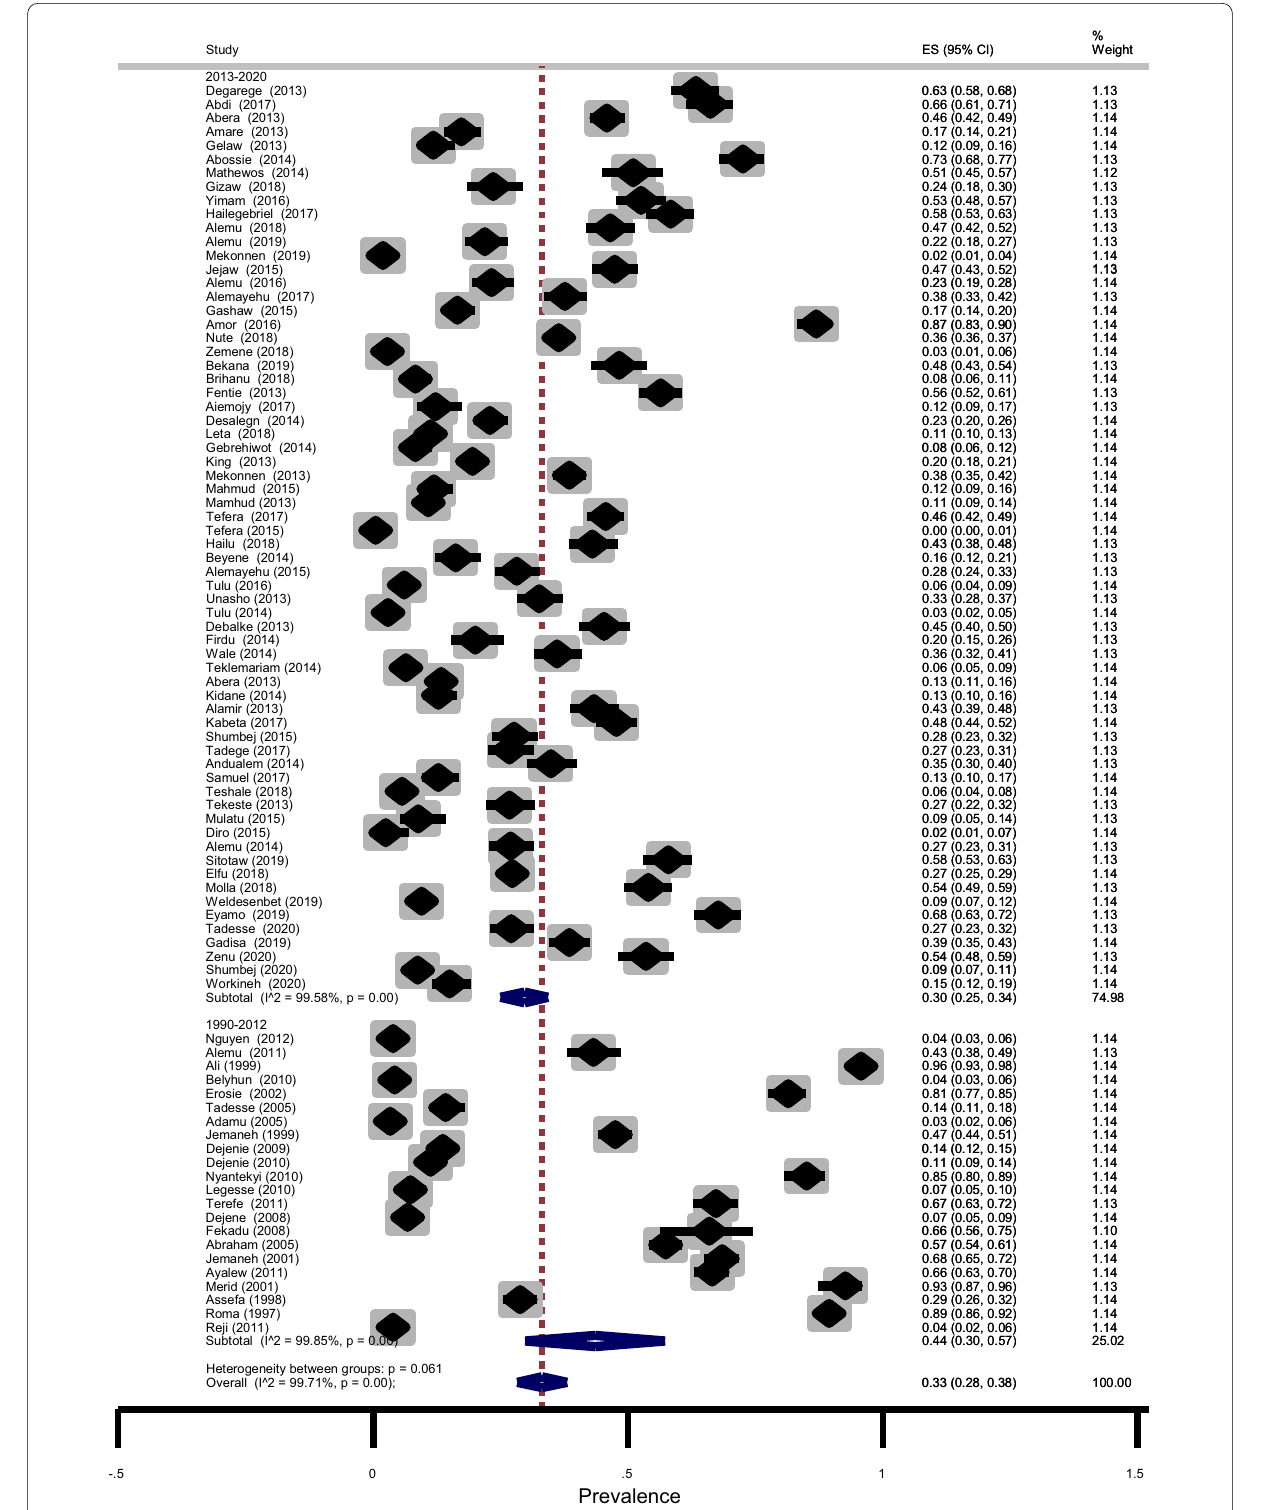
Fig. 8 Forest plot showing prevalence of STHs by year of